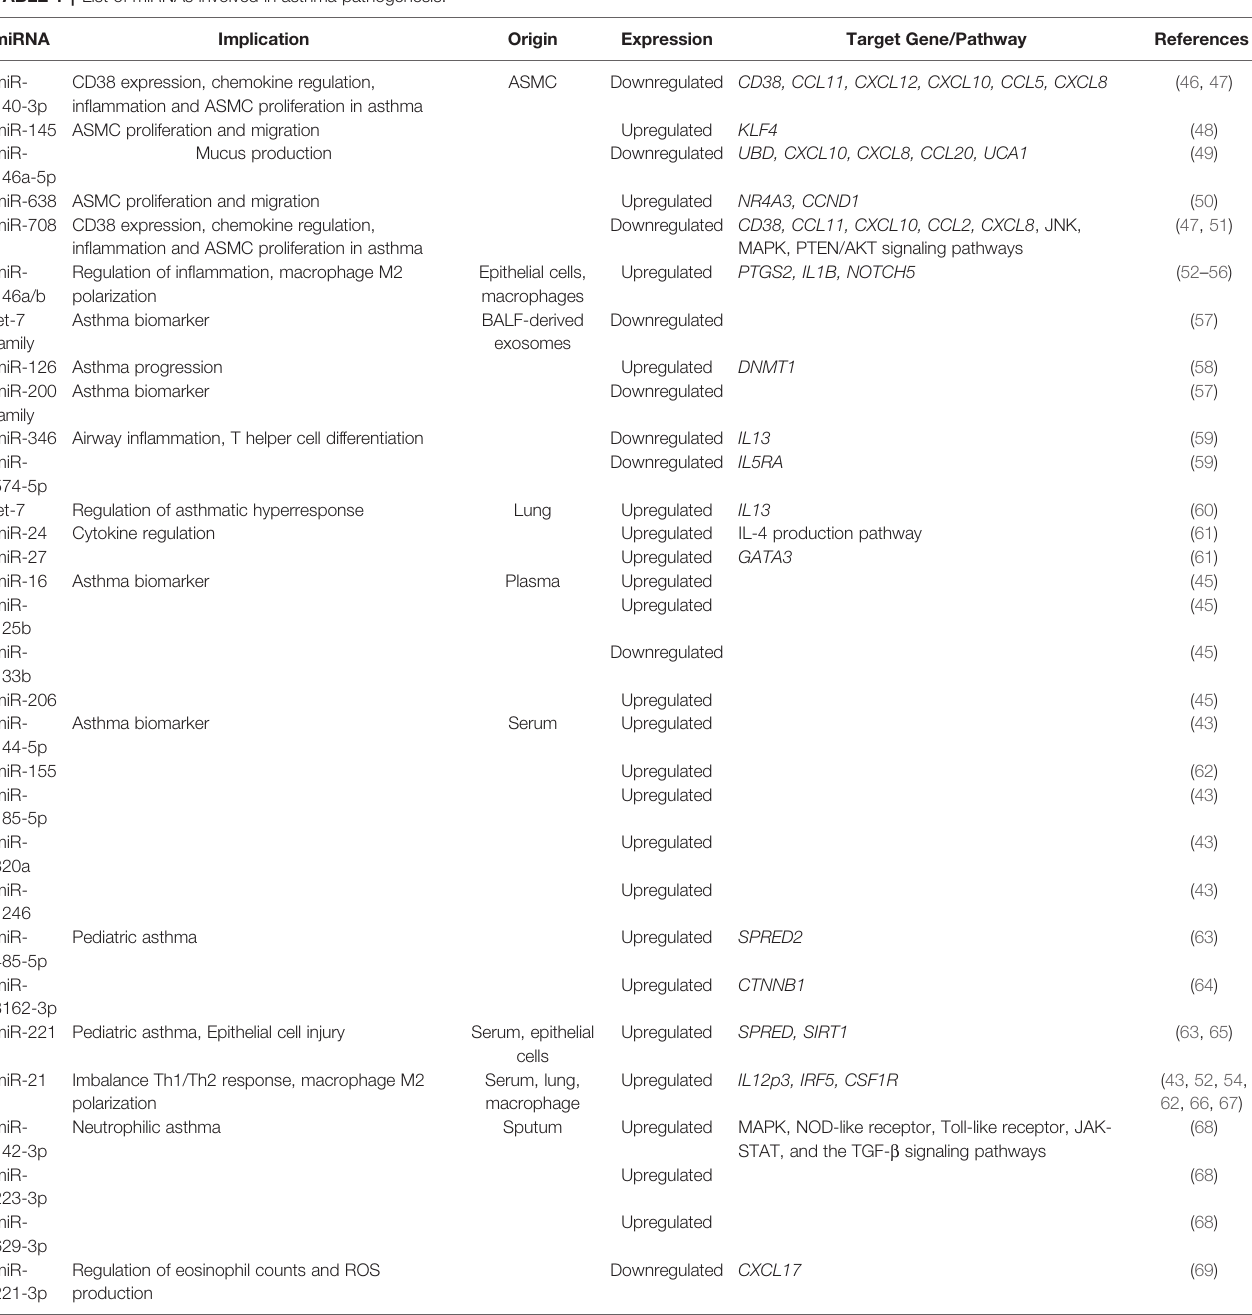
TABLE 1 | List of miRNAs involved in asthma pathogenesis.